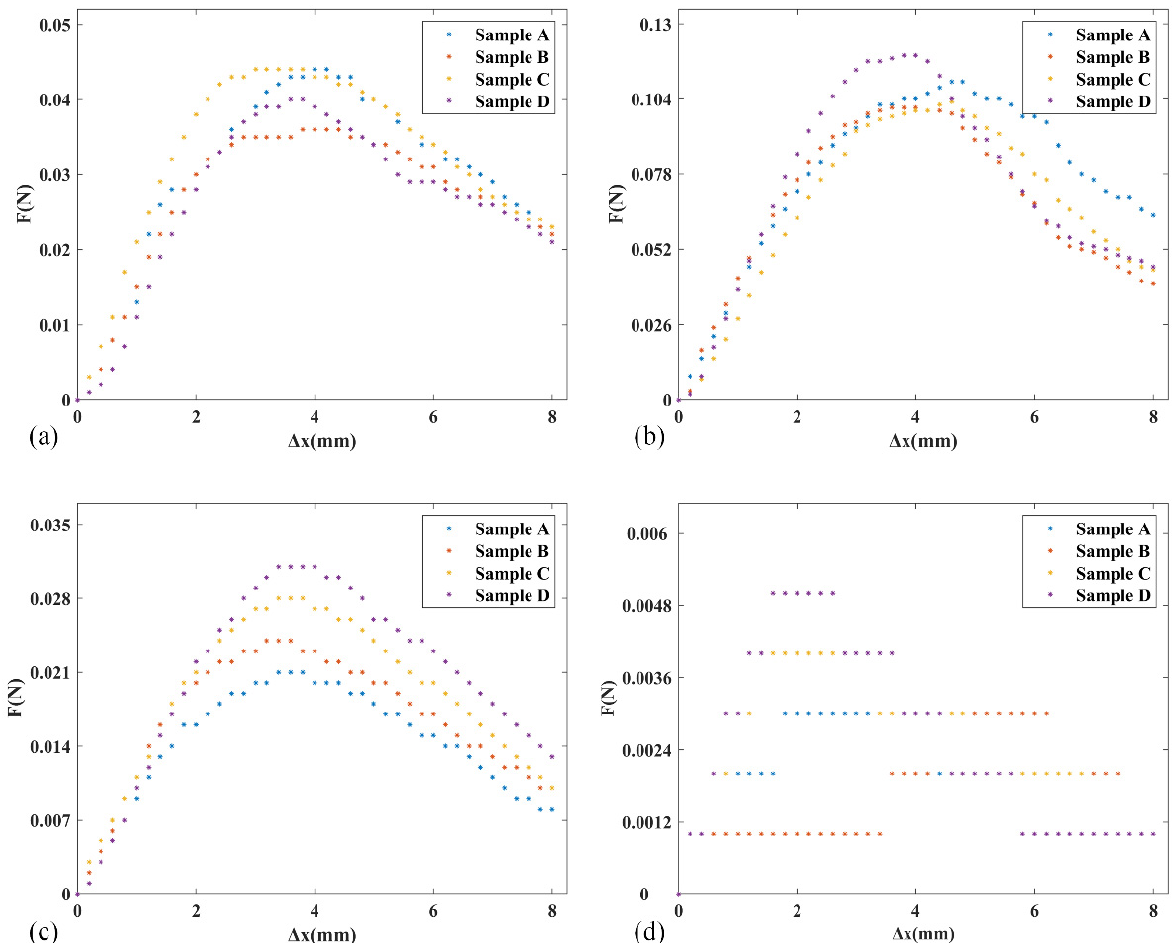
Figure 9. The relationship curves between F , Δ x and four different brush samples: ( a ) The relationship between F and Δ x for four brush samples of nylon material. ( b ) The relationship between F and Δ x for four brush samples of bristle material. ( c ) The relationship between F and Δ x for four brush samples of nanometer-silk material. ( d ) The relationship between F and Δ x for four brush samples of wool material.